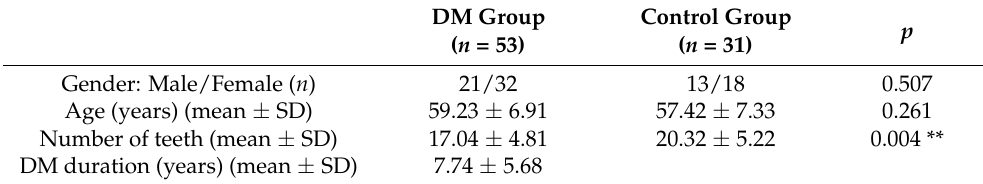
Table 1. Patient characteristics at baseline.